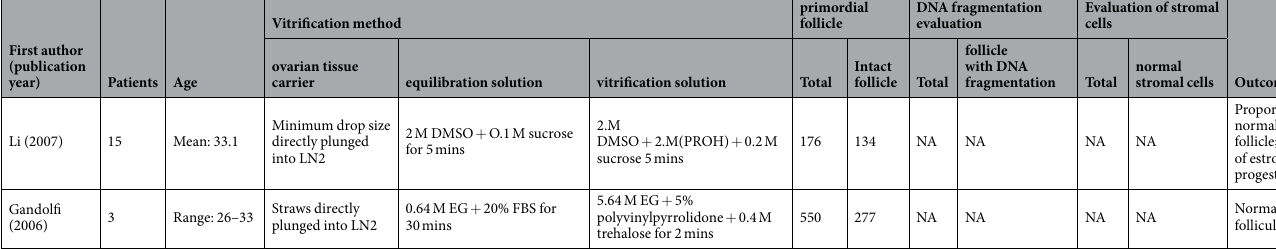
Table 1. Basic characteristics and outcomes of studies included. EG = ethylene glycol, DMSO = dimethyl sulphoxide, PrOH = 1,2-propanediol, NA = not applicable, NR = not reported, M = mol/L * Data were presented as range and/or mean (standard